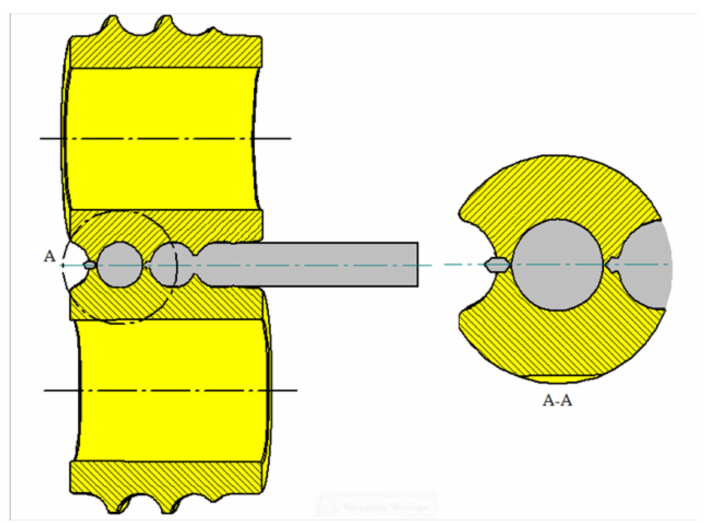
Figure 8. Ball splitting diagram on second type